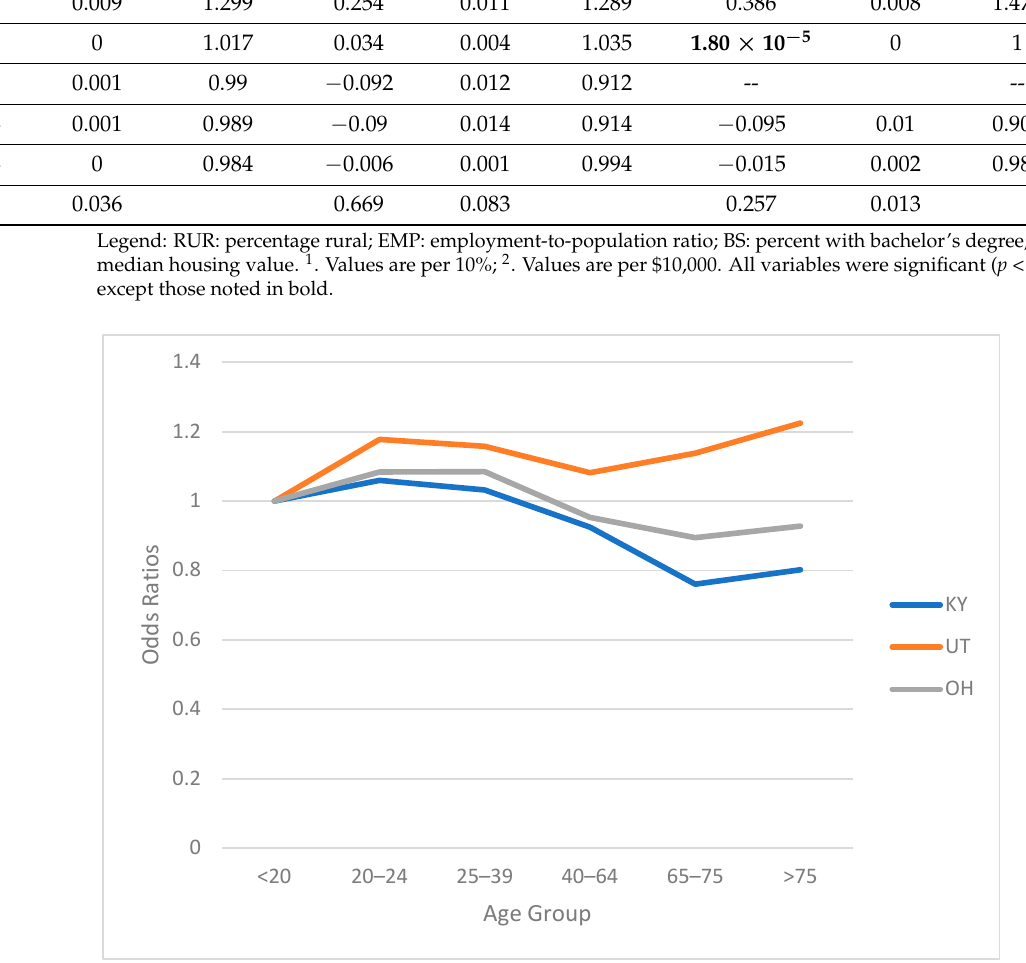
Figure 1. Odds ratio for age groups.